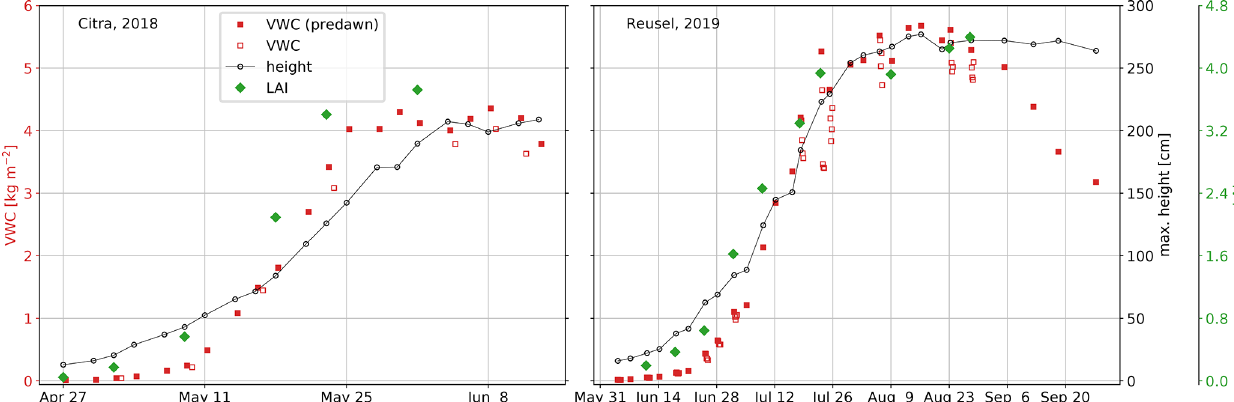
Figure 2. Vegetation water content (VWC), crop height, and leaf area index (LAI) from the field experiments in Citra (2018) and Reusel (2019). Filled red markers indicate predawn measurements, while open markers indicate non-predawn measurements at 18:00LT (2018) and morning to sunset (2019).